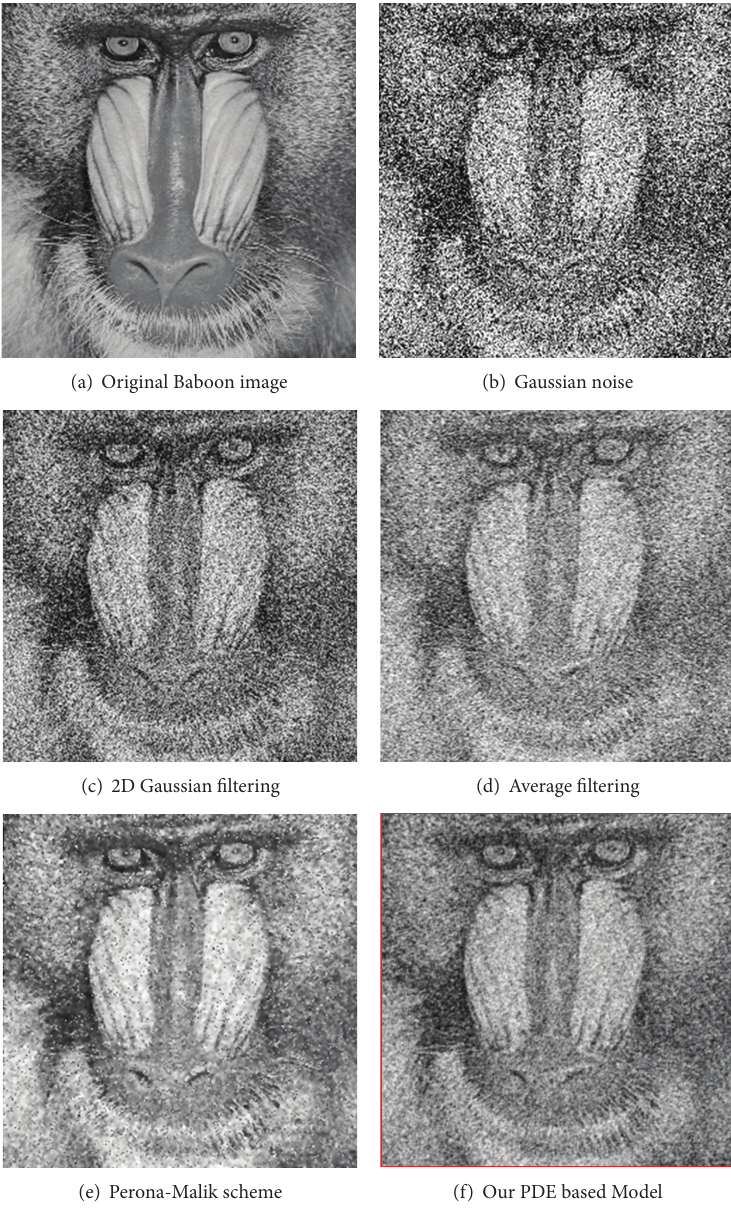
Figure 2: Noise removal results provided by our model and other denoising